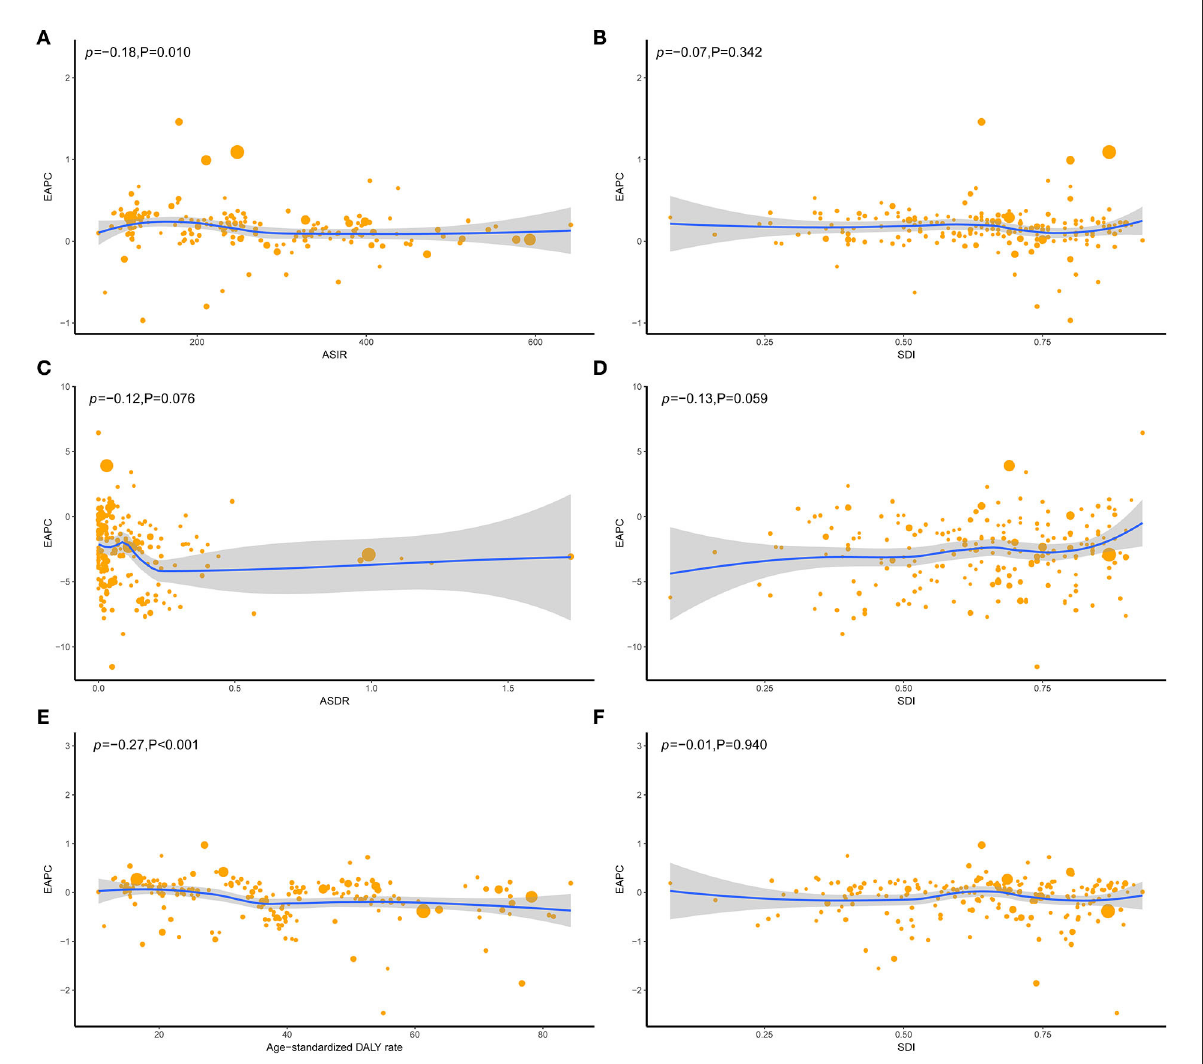
FIGURE2 The correlation between EAPC and UFs ASR [incidence (A) , death (C) , and DALY (E) ] in 1990 and SDI [incidence (B) , death (D) , and DALY (F) ] in 2019. The circles represent countries that were available on SDI data. The size of the circle represents the number of UFs patients, and one circle represents a specific country. The ρ indices Pearson’s correlation coefficient and P -values were derived from Pearson’s correlation analysis. ASR, age-standardized incidence/death/DALYs rate; EAPC, estimated annual percentage change; SDI, socio-demographic